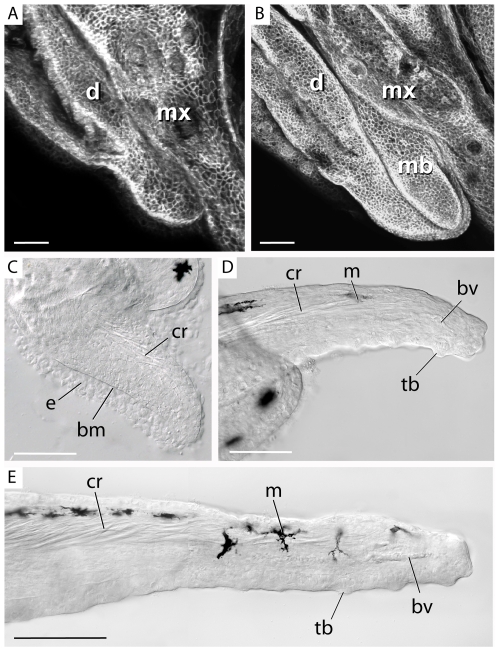
Early development of the maxillary barbel bud.
A) Whole-mount confocal microscopy of the lower jaw of a juvenile membrane–GFP (mGFP) transgenic zebrafish (<10 mm standard length). Anterior is to the left. The maxillary barbel bud is not yet visible between the adjacent maxilla (mx) and dentary (d). All scale bars = 50 µm. B) Corresponding view of a slightly larger mGFP juvenile (10–12 mm SL). The first sign of the maxillary barbel (mb) is a rounded bud projecting caudoventrally. C) The early barbel bud has a thick outer epithelium (e) and a dense mesodermal core. The two layers are separated by a prominent basement membrane (bm). Fine strands of birefringent matrix accumulate dorsally where the central rod (cr) will form. D) As the barbel grows, the central rod becomes denser and projects farther distally. Isolated melanophores (m) appear along the dorsal epithelium. Ventrally, the blood vessel loop (bv) is forming. The ventral epithelium and distal tip carry numerous taste buds (tb). E) Later stages of barbel development involve expansion of the earlier structures. The central rod becomes longer and denser, the capillary loop extends, multiple melanophores become spaced along the dorsal surface, and numerous taste buds are added. The lymph vessel is not yet patent. bm = basement membrane; bv = blood vessel; cr = central rod; d = dentary; e = epithelium; m = melanophore; mb = maxillary barbel bud; ms = mesenchyme; mx = maxilla; o = orbit; tb = taste bud.